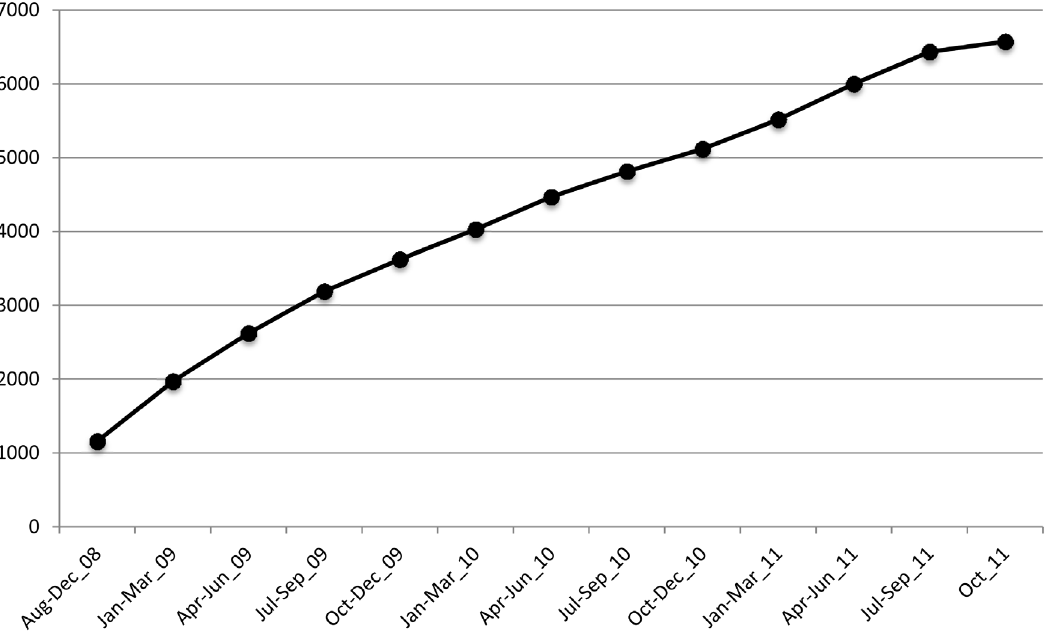
Figure 1. Cumulative enrollment of female sex workers at the SWOP-City Clinic in the Nairobi Central Business District, Aug 2008 until Oct 2011.